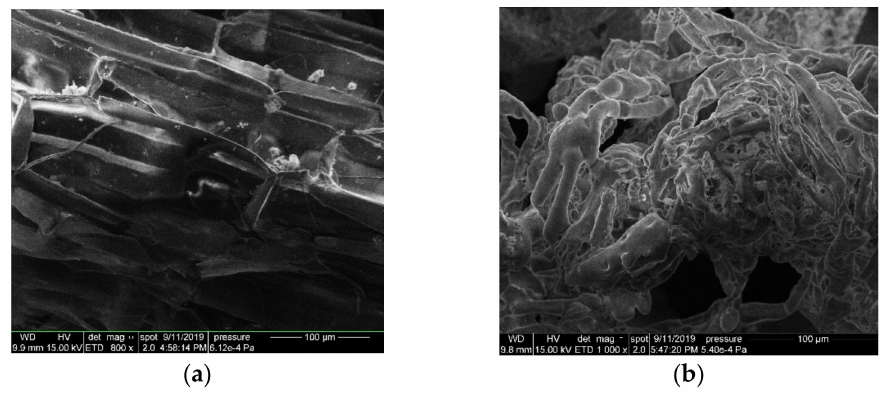
Figure 1. SEM images of ( a ) raw WS ( b ) WS